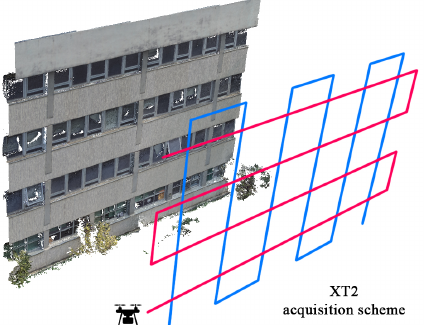
Figure 4 . Alvaro-Gobetti school acquisition scheme (crossing flight paths in red and blue).